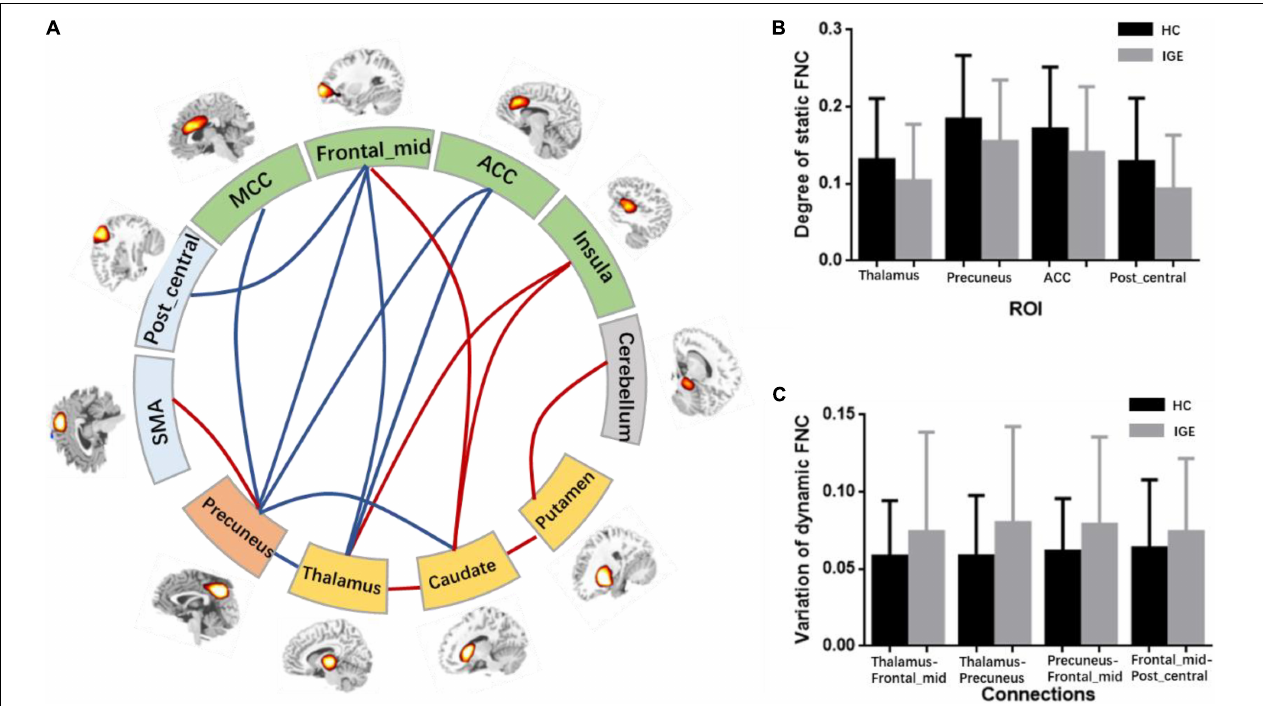
FIGURE 3 | (A) Abnormal FNCs in IGE. This figure contained regions with significant alteration of FNC. The red lines represented the enhancement of connections in IGE and the blue lines represented the decrease of FNCs in IGE. (B) The degree of the static FNC nodes in IGE and HC, and significant decreased degree of thalamus, precuneus, ACC and post_central area was found in IGE. (C) The variation of dynamic FNCs in IGE and HC, and increased variation was found in thalamocortical and cortical–cortical